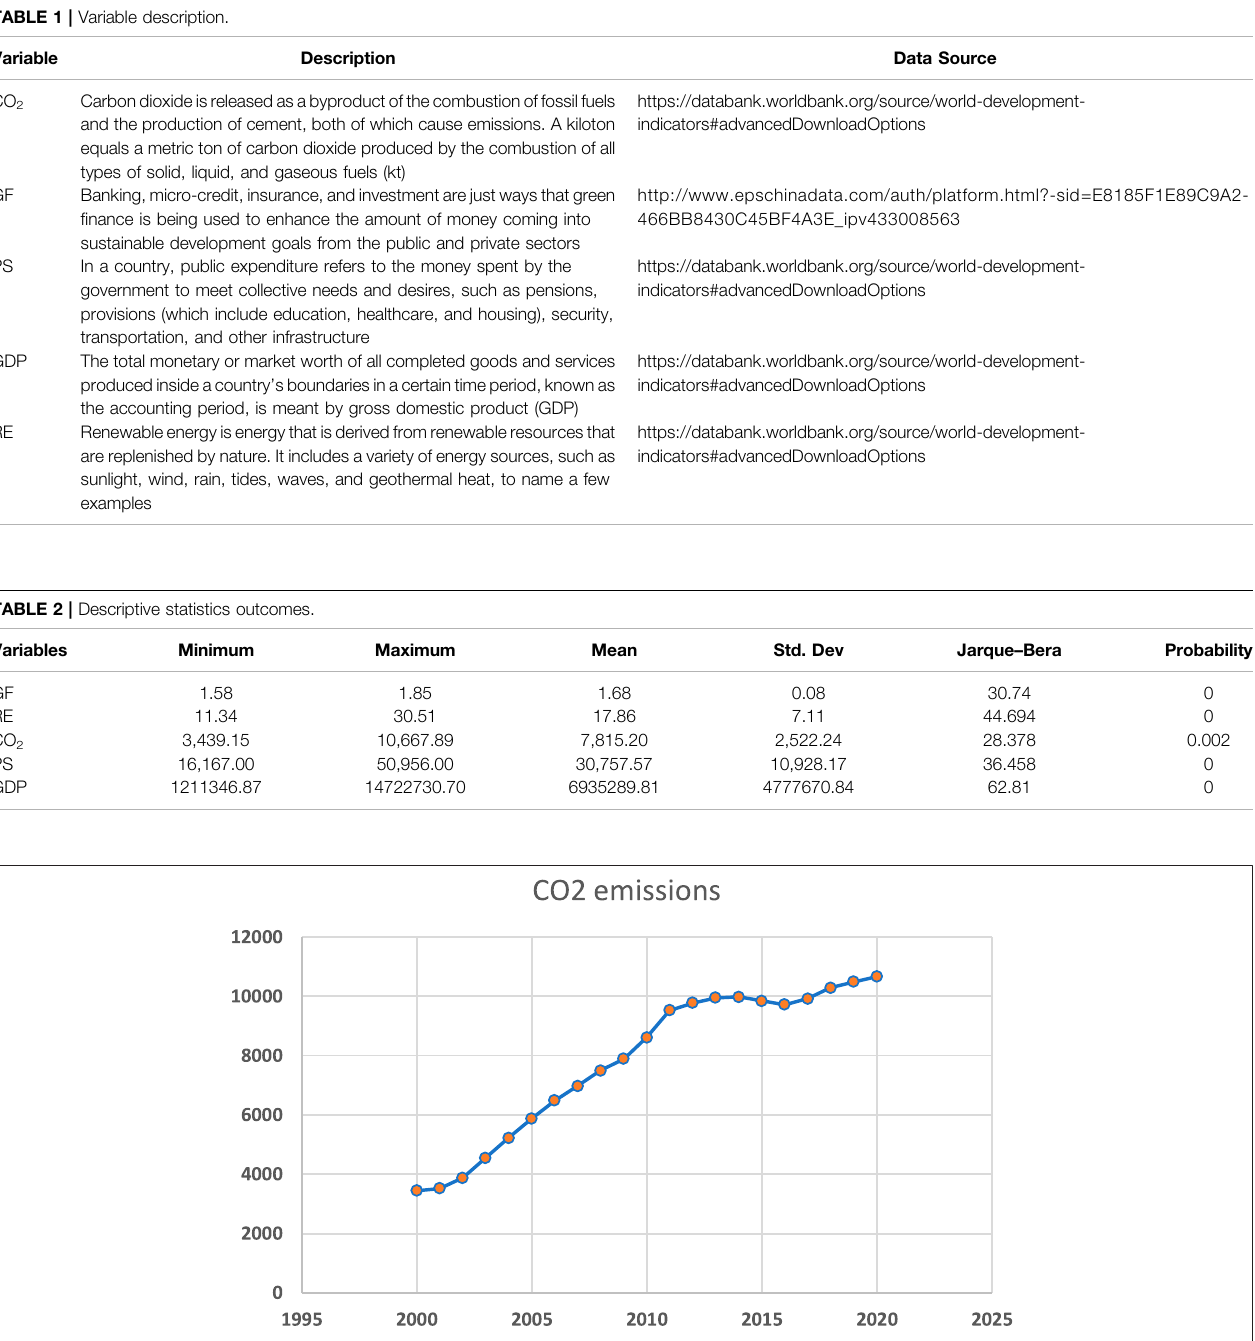
FIGURE 1 | China ’ s CO 2 emissions from 2000 to